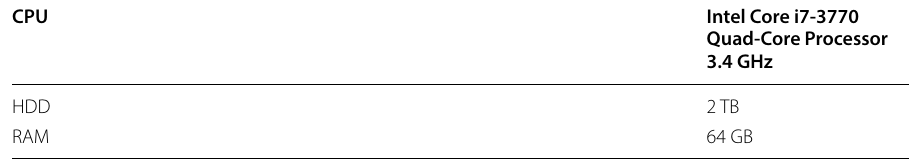
Table 12 Mapper node specifications